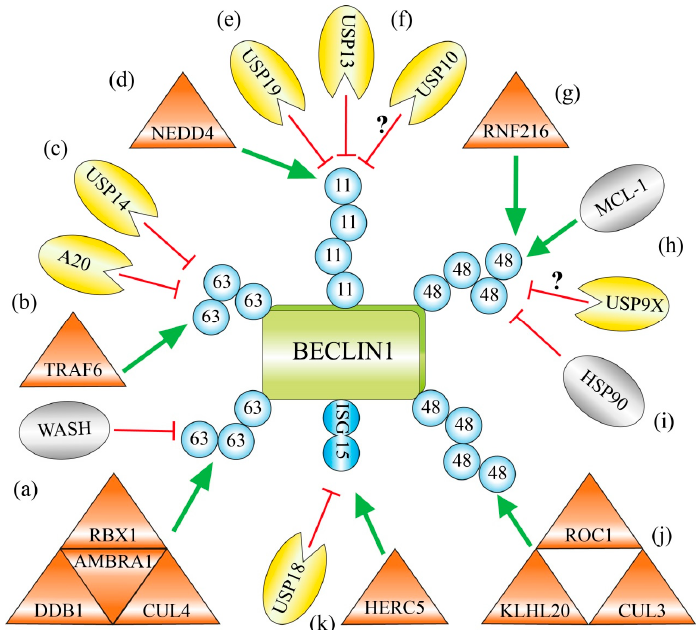
Figure 2. Regulation of BECLIN 1 by ubiquitination and ISGylation. Ubiquitin chains linked via Lys63